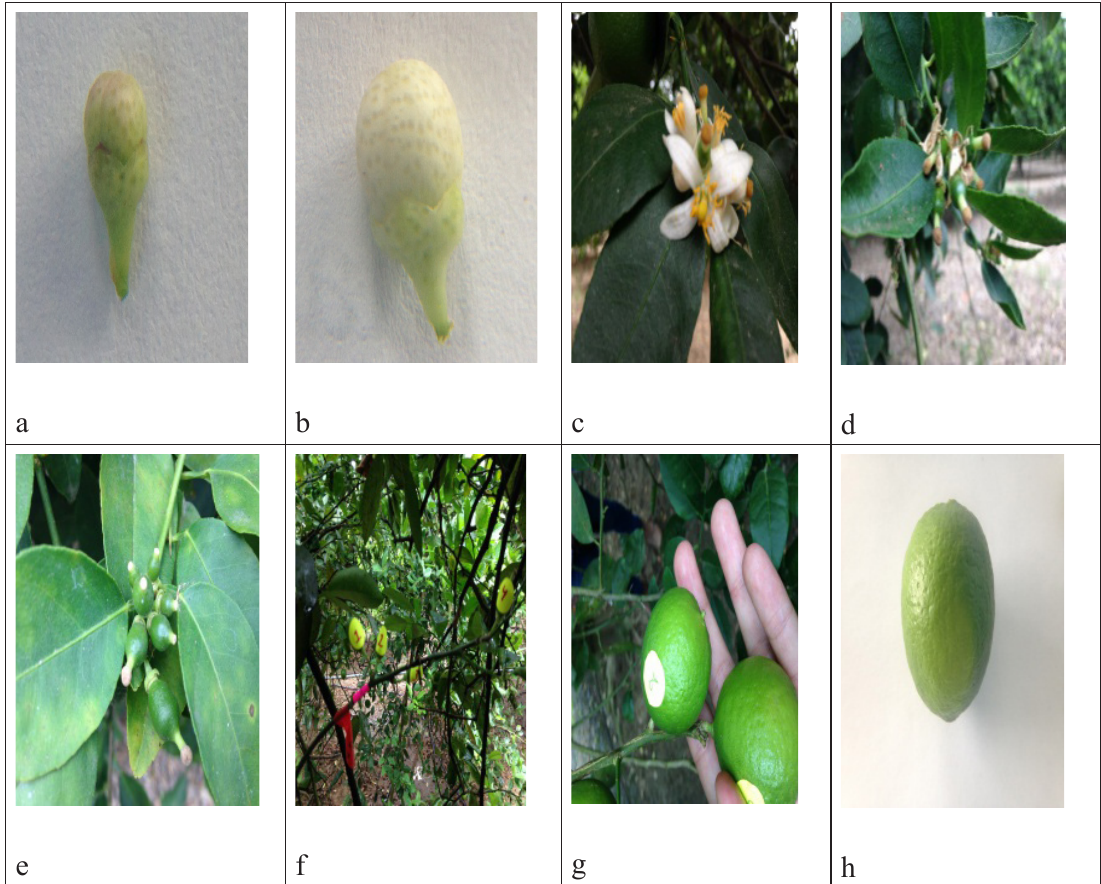
Figure 2. Graphic illustration of the reproductive stages of limón. Source: Images . Caballero Mario, 2018.Pale green– white closed button (a); open button (b); open flower (c); senescent (dry) phase; falling petals (d); appearance of new fruits (e); fruiting (f); background colour (g) and appearance of coating colour (h). Graphs based on BBCH scale of citrus (Agustí,